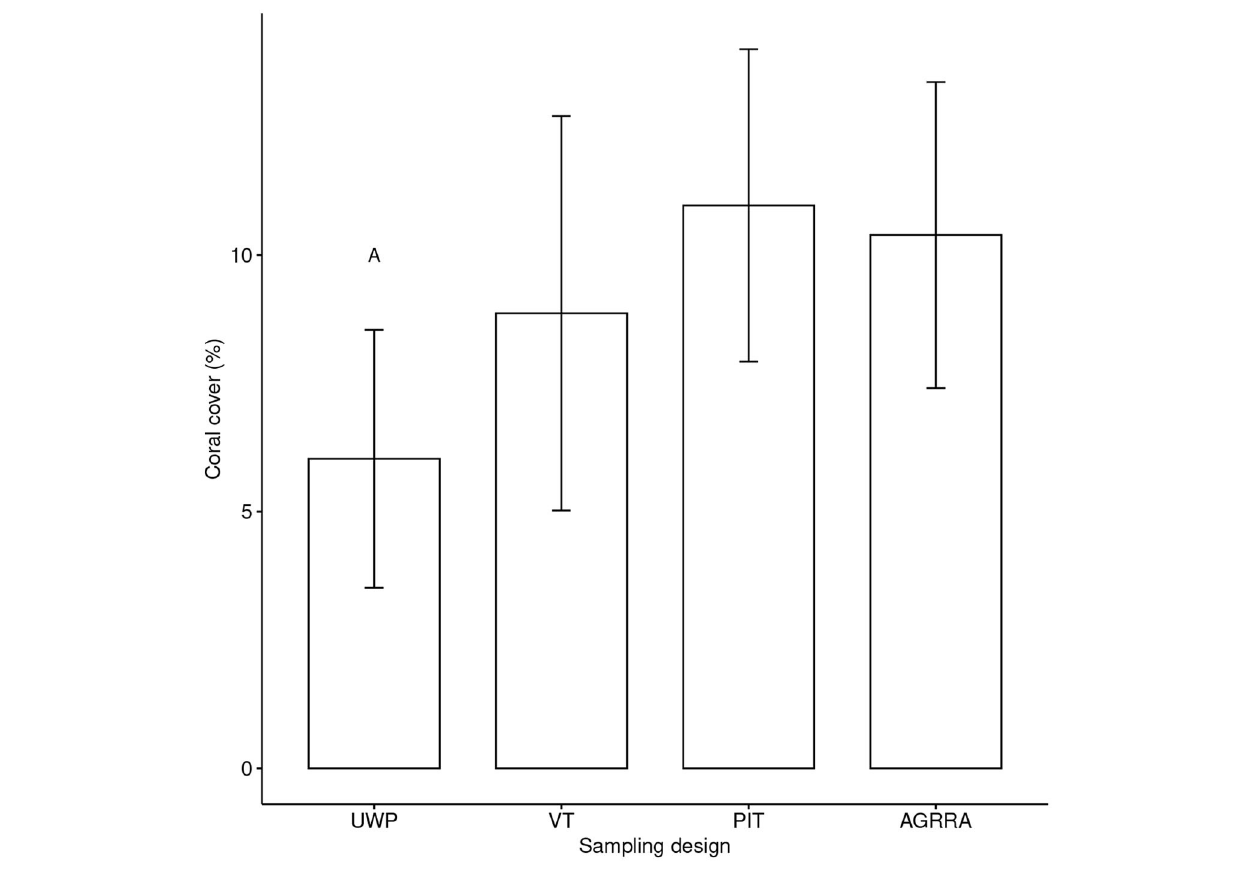
FIGURE 6 | Average percentage of coral cover ( ± SD) estimated with each sampling design. Underwater digital photogrammetry (UWP), videotransect (VT), point intercept transect (PIT), and Atlantic and Gulf Rapid Reef Assessment (AGRRA). The letter indicates the sampling design where the percentage of coral cover was significantly different ( p <